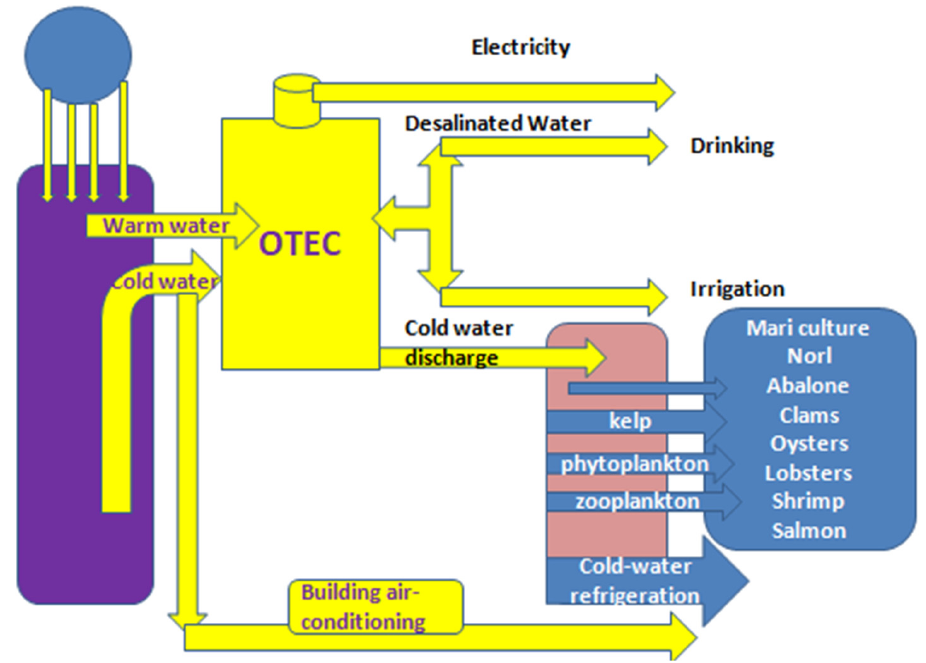
Figure 14. Byproducts from an open-cycle OTEC. Table 6. Running demonstration projects for OTECs in several countries.